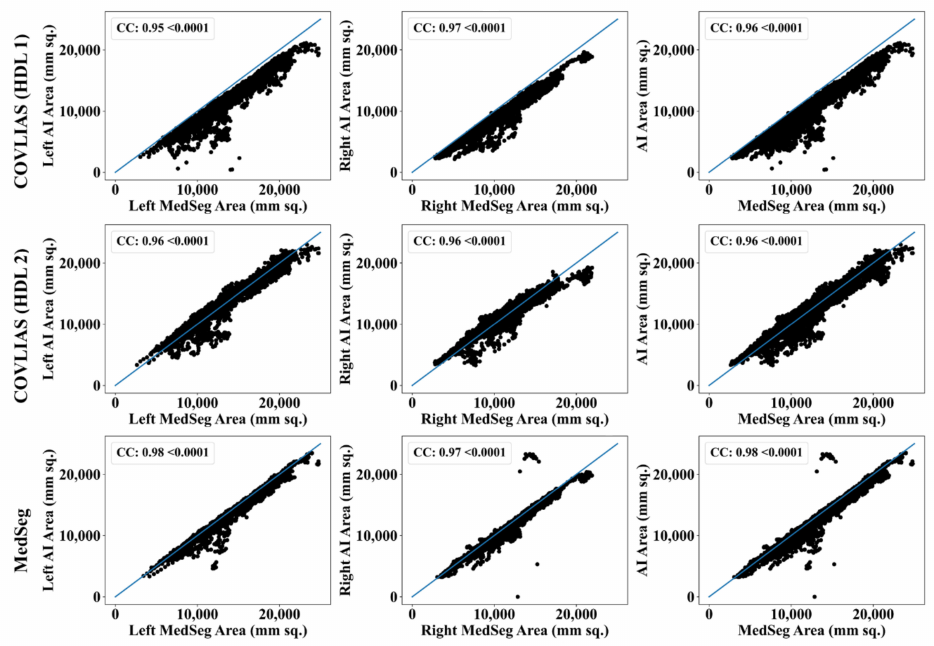
Figure 13. CC plots: COVLIAS (row 1 and row 2) vs. MedSeg (row 3) using MD 1. Column 1: left lung, column 2: right lung, and column 3: mean of left and right lungs. COVLIAS (HDL 1): VGG-SegNet; COVLIAS (HDL 2):